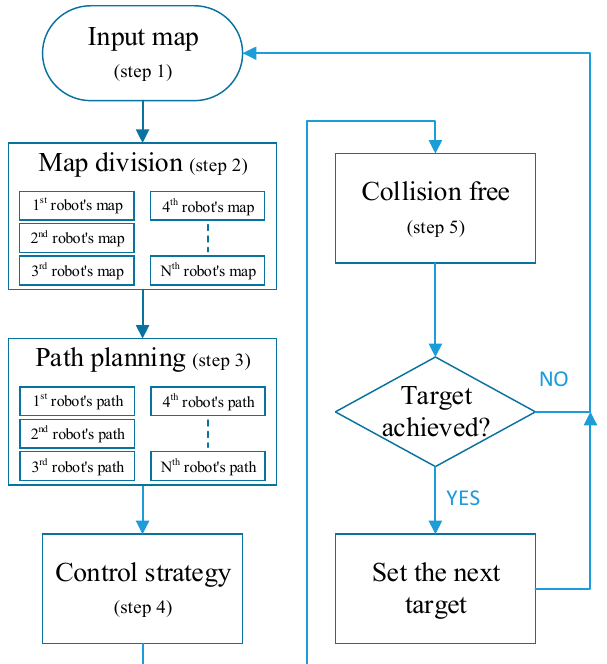
Figure 1. Flow chart of multi-robot path planning.